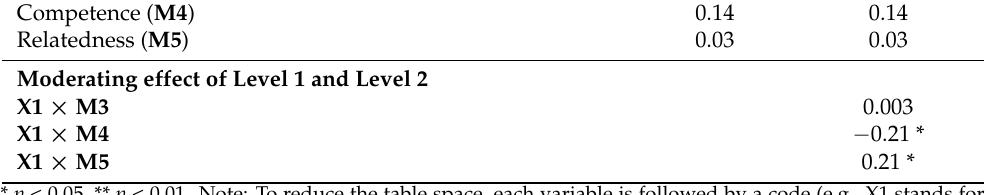
Figure 2. Moderating effect of ICT usage and relatedness on emotional experience. 4. Discussion The current study shows that the communication app, Line, used on mobile phones is a feasible tool for measuring the daily experience of older adults. First, this data collec- tion method can help obtain more immediate data than paper questionnaires. In addition, past studies have shown that online versions of questionnaires are considered more satis- factory than paper versions (Touvier et al. 2010). Furthermore, older adult participants were more committed to participating in the investigation because we made proper use of the communication app to interact with them and to design a collection of points to make them more willing to use it. Participants in the current study who successfully re- ported valid data reached a very high percentage. This success can be attributed to the fact that the researchers designed the app based on the needs of older adults and used game design elements, including incentive systems (Plass et al. 2015). The abovemen- tioned data collection results also represent an effective survey tool designed for the cur- rent research. This method has seldom been used to measure the emotional experiences of older adults in previous studies. Past studies have also shown that the use of ESM for older adults requires further development (Myin-Germeys et al. 2018). The current re- search provides an innovative way to use ESM with older adults and can be a reference for future studies. In addition, the current research reveals the daily experiences of older adults and their use of ICT. It is indicated that their experience may be related to their emotional experience. The highlights of this study are discussed below. 4.1. Older Adults Have a More Positive Emotional Experience When They Use ICT It was found that the daily transient experiences of older adults are related to their emotional experiences. When older adults use ICT, they have a more positive emotional experience. This finding is similar to past research showing that using ICT can enhance the positive emotions of older adults (Morris et al. 2014; Tkatch et al. 2021). Moreover,